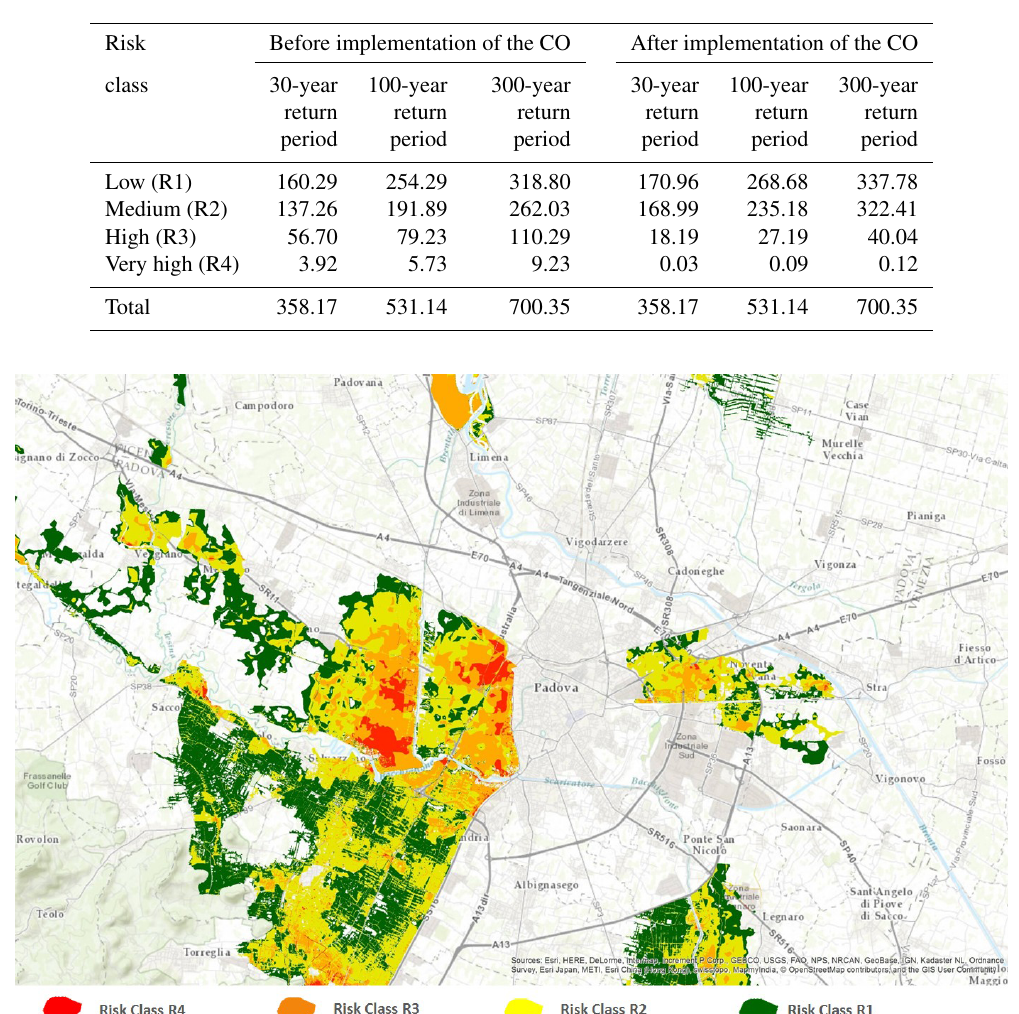
Figure 6. Risk map for the metropolitan area of Padua for a 100-year flood event before implementation of a CO on flood risk management. Sources: Esri, HERE, DeLorme, Intermap, Increment P. Corp., GEBCO, USGS, FAO, NPS, NRCAN, GeoBase, IGN, Kadaster NL, Ordnance Survey, Esri Japan, METI, Esri China HongKong, swisstopo, MapmyIndia, © OpenStreetMap contributors 2020. Distributed under a Creative Commons BY-SA License and the GIS user